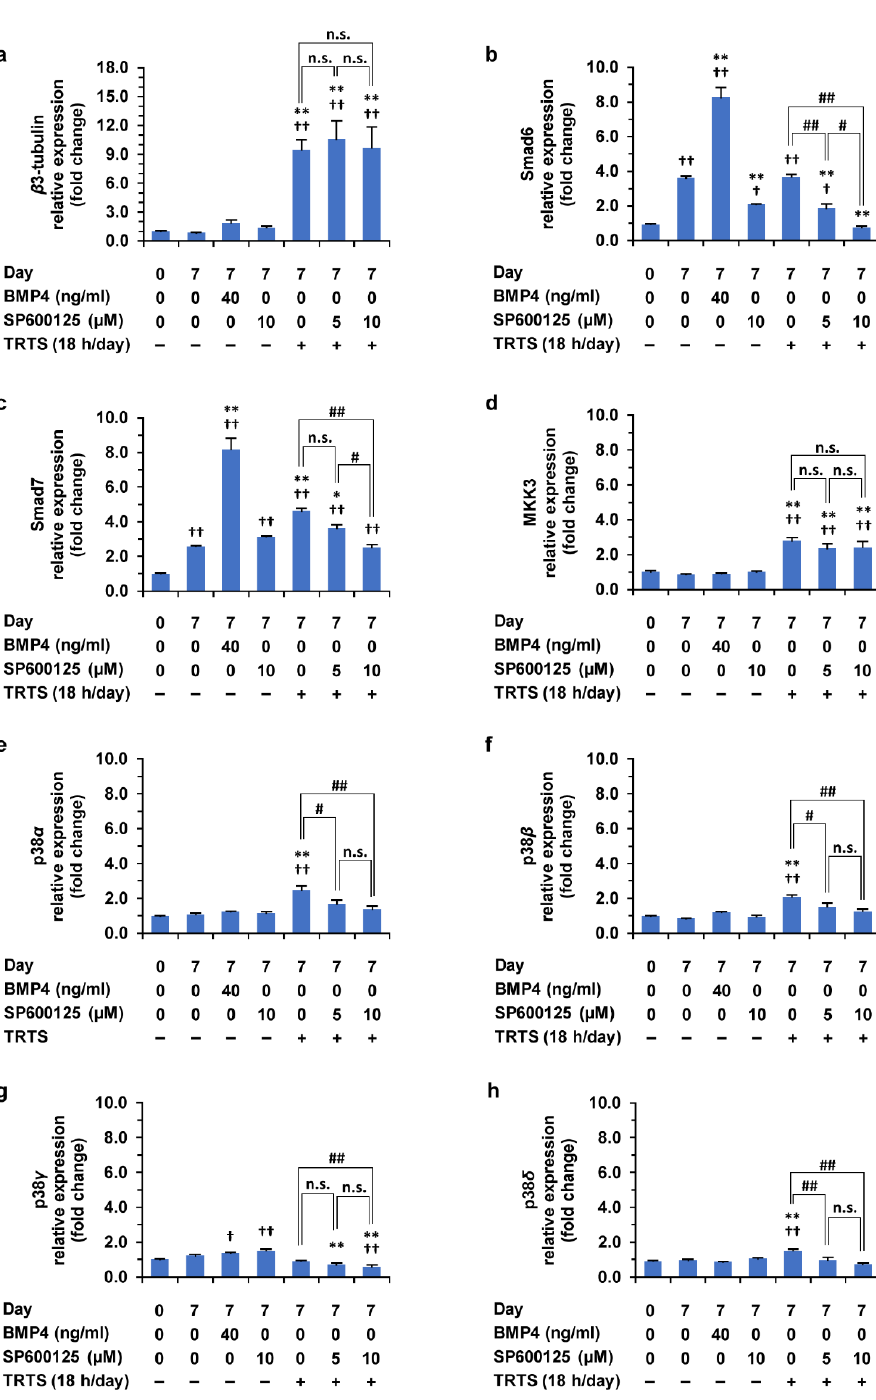
Figure 10. ( a – h ) Effects of TRTS in the presence or absence of SP600125 on gene expressions in PC12-P1F1 cells. PC12-P1F1 cells were incubated with BMP4 (40 ng/mL) or SP600125 (10.0 µ M) for 7 days. In addition, PC12-P1F1 cells were also treated with TRTS for 18 h per day for 7 days in the presence of the indicated SP600125 concentrations. The target mRNA expression was normalized to that of the internal control β - actin. β3 -tubulin was used as a neuronal differentiation marker of the cells. For each indicated gene, results are presented as fold changes relative to day 0 of the control: β 3-tubulin ( a ), Smad6 ( b ), Smad7 ( c ), MKK3 ( d ), p38 α ( e ), p38 β ( f ), p38 γ ( g ), p38 δ ( h ). The data represent the means ± standard deviation of three replicates. # p < 0.05; ## p < 0.01; † p < 0.05 vs. day 0 control; †† p < 0.01 vs. day 0 control; * p < 0.05 vs. day 7 control; ** p < 0.01 vs. day 7 control; n.s., not